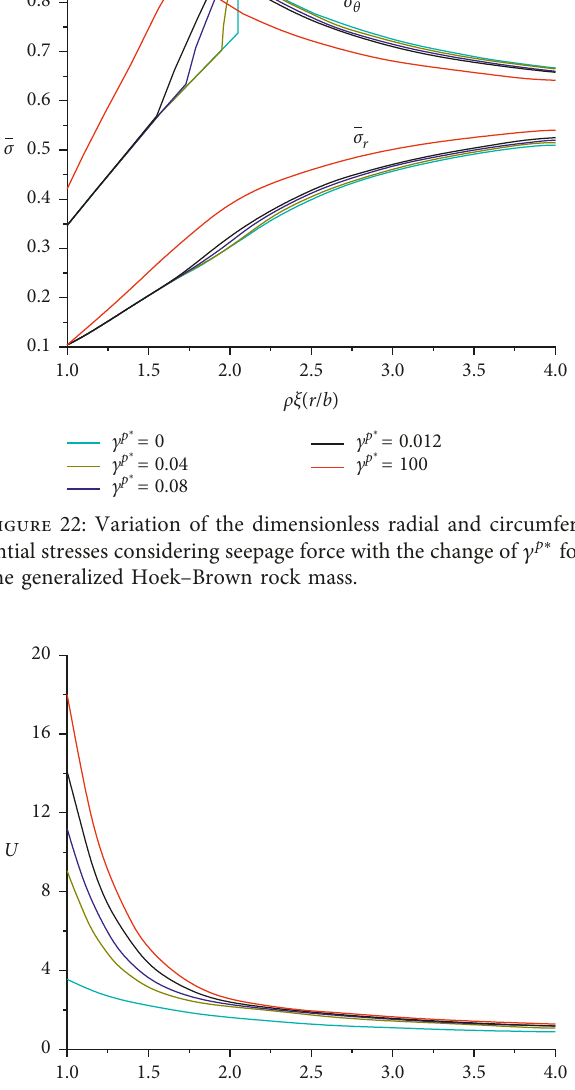
Figure 21: Comparison between dimensionless displacement with and without considering seepage force for Hoek–Brown rock mass.